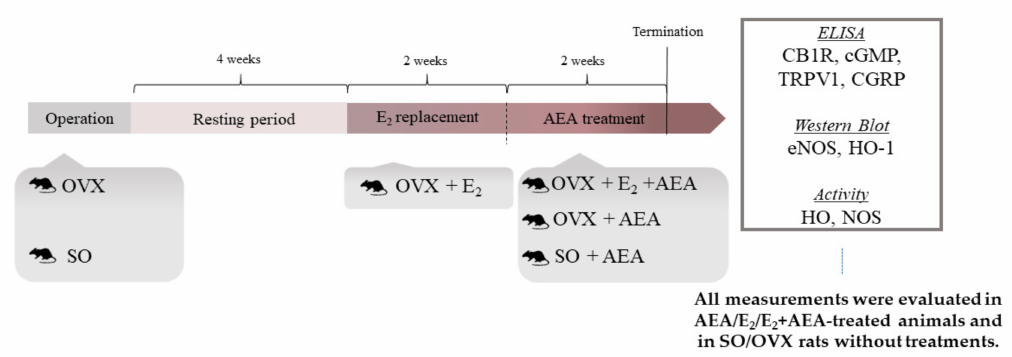
Figure 7. Experimental design of the